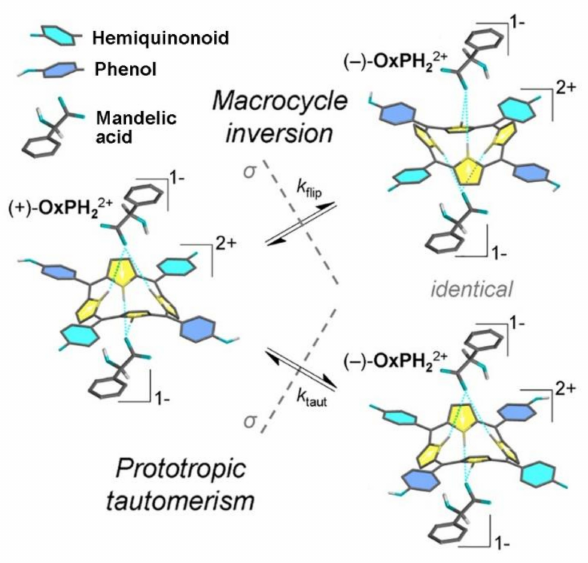
Figure 4. Macrocyclic inversion dynamics (ring-flip) and prototropic tautomers. The (–)- OxPH 2 2+ structures at the right are identical (related by a 90 ◦ rotation around axes perpendicular to the OxPH 2 2+ mean plane). Adapted with permission from Ref. [44]. Copyright 2014 American Chemi- cal